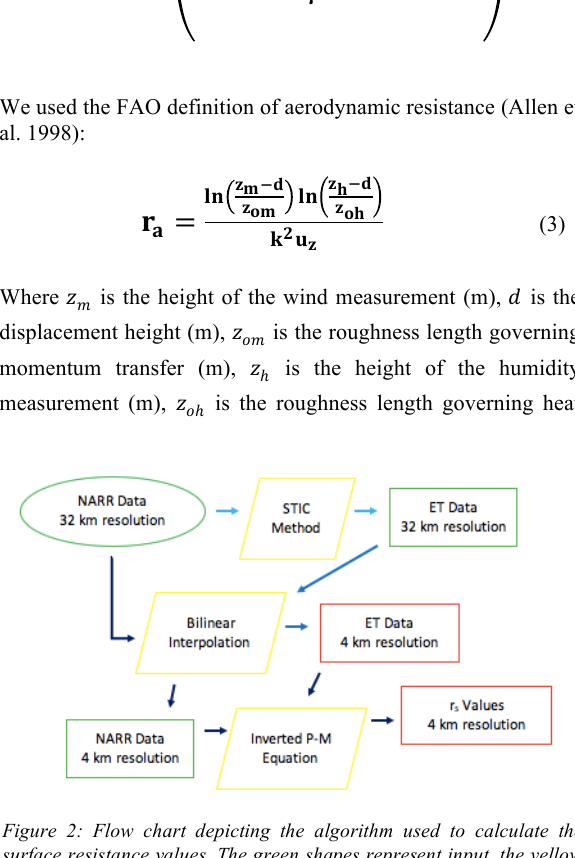
Figure 3: This figure shows the correlation between the ET data collected by INFLUX and the ET data calculated by STIC. The flux tower is located on the West side of Indianapolis, and data was used from January to July